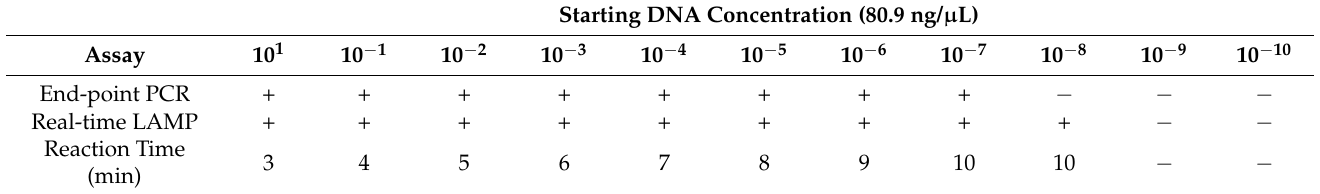
Table 4. Comparison of the sensitivity of the real time LAMP and end-point PCR.